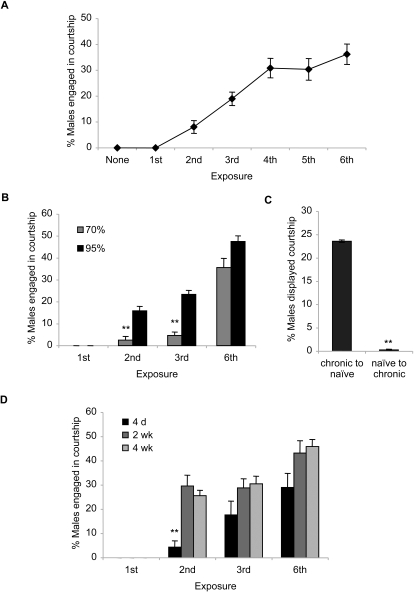
Effects of recurring ethanol exposure on courtship behavior of CS males.(A) The percentage of males engaged in intermale courtship progressively increased upon additional ethanol treatments in 95% Flypub. Least squares regression showed the significant effect of exposure (r2 = 0.68, p<0.0001, n = 10). (B) CS males subjected to daily ethanol exposure in 70% Flypub exhibited the exposure-dependent increase in intermale courtship but at the significantly reduced levels compared to those challenged with 95% ethanol. Two-way ANOVA revealed the significant effects of ethanol concentration, exposure, and interaction (concentration effect, F1,24 = 54.02, p<0.0001; exposure effect, F3,24 = 138.2, p<0.0001; interaction, F3,24 = 6.7, p = 0.0019; n = 4). Post hoc two-tailed Student t-test showed the significant difference of the courtship scores on the 2nd (p<0.005) or 3rd exposure (p<0.0005) (marked by double asterisks). (C) The chronic-ethanol-treated males displayed active courtship toward the decapitated previously-ethanol-naïve males under the influence of ethanol (chronic to naïve), whereas the ethanol-naïve males, on the 1st ethanol exposure, displayed negligible courtship toward the decapitated chronic-ethanol-exposed males (naïve to chronic). Two-tailed Student t-test showed a significant difference (p<0.0001, n = 6, marked by double asterisks). (D) Two or 4 wk-old CS males exhibited the increased levels of intermale courtship compared to 4 d-old males when tested in 95% Flypub. Two-way ANOVA revealed the significant effects of age and exposure, and a marginal interaction (age effect, F2,36 = 16.6, p<0.0001; exposure effect, F3,36 = 61.7, p<0.0001; interaction, F6,36 = 2.58, p = 0.035; n = 4). Tukey-Kramer tests showed that the intermale courtship activities of 2 and 4 wk-old males were significantly different from that of 4 d-old males on the 2nd exposure (marked by double asterisks).